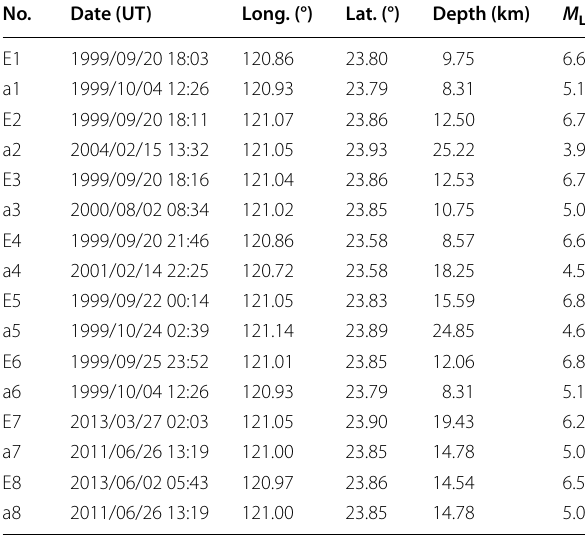
Table 1 Earthquake parameters for the target events and EGF events determined by CWB